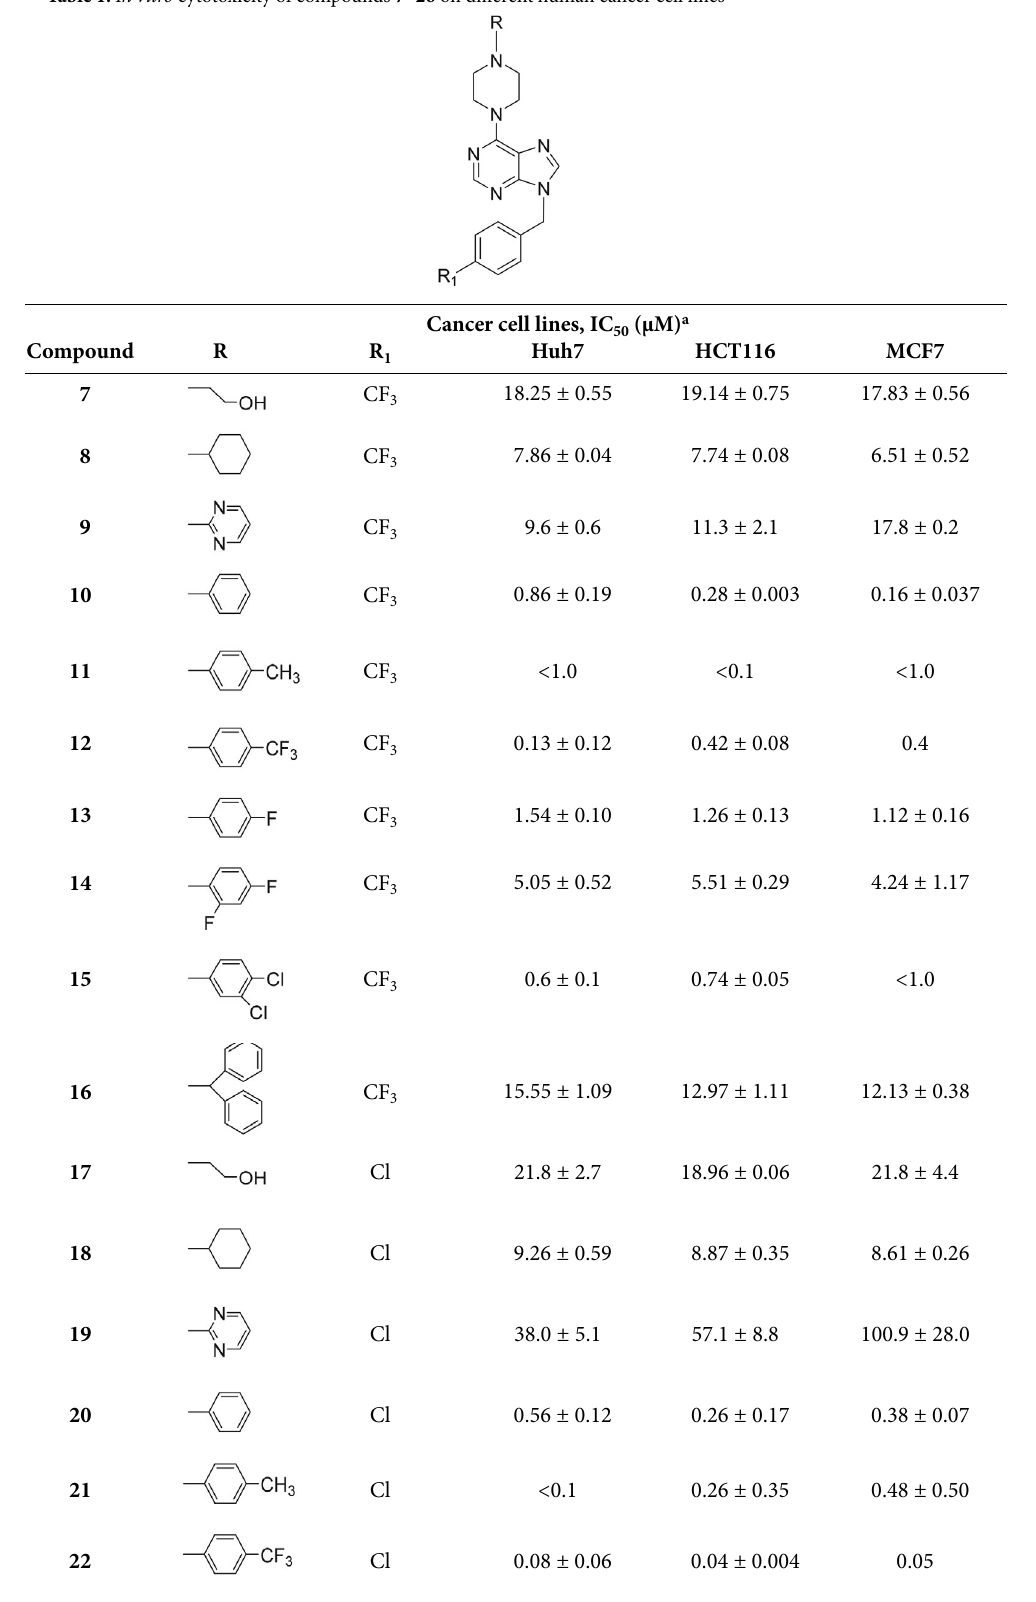
Table 1. In vitro cytotoxicity of compounds 7 – 26 on different human cancer cell